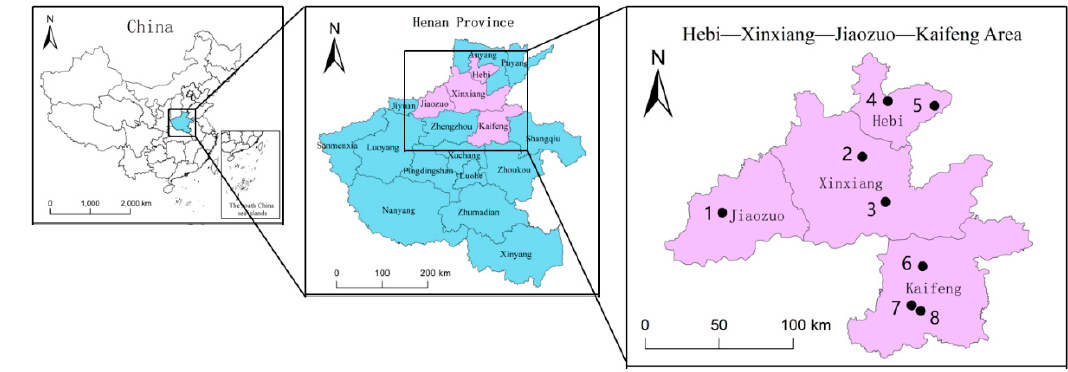
Figure 2. Locations of the field survey area and representative villages.